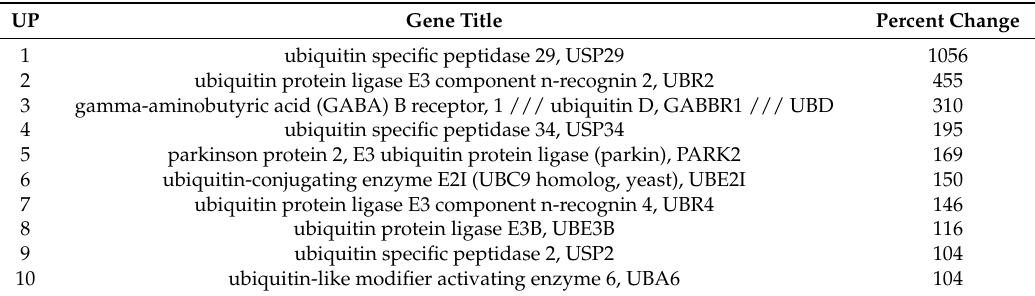
Table 10. GHK and Genes Associated with the Ubiquitin Proteasome System.